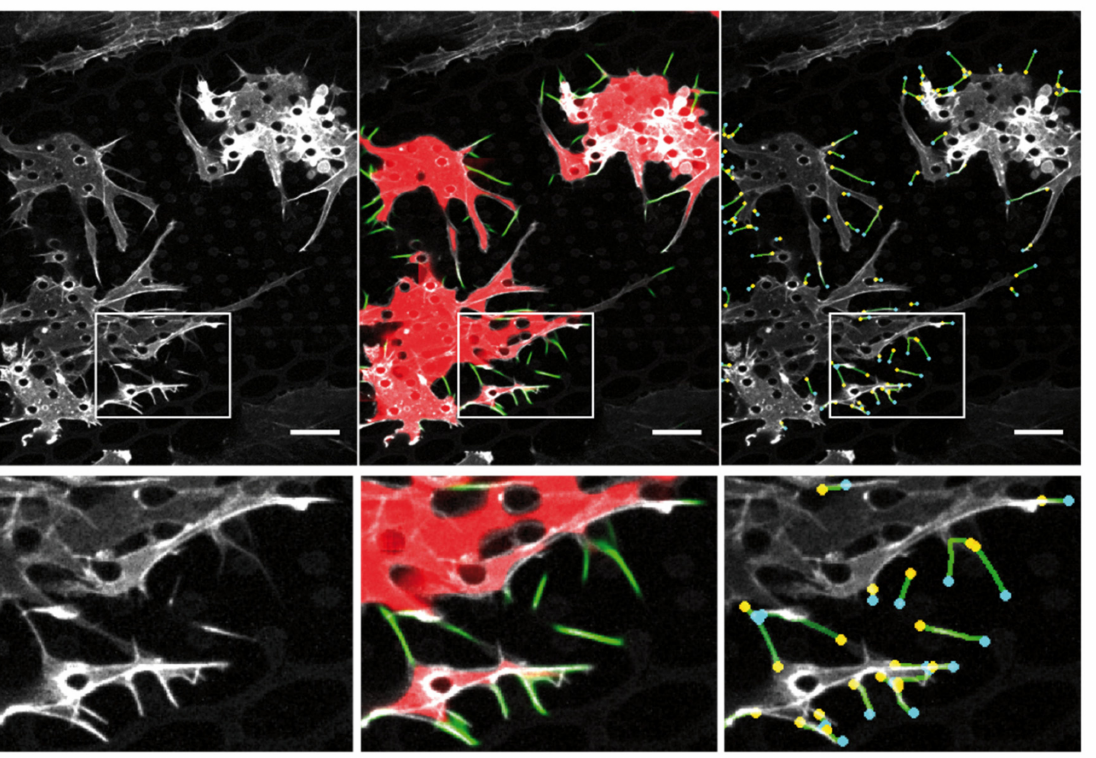
Figure 5. Automated filopodia detection. Left, original image of Lifeact-GFP HUVECs cells in the microstructures. Middle, automatic detection of cell islets ( red ) and filopodia ( green ). Right, detection of ( − ) and (+) extremities for each individual filopodia, used for filopodia tracking. Bottom, zoom on the image part in the white rectangle on top. Scale bar 15 µ